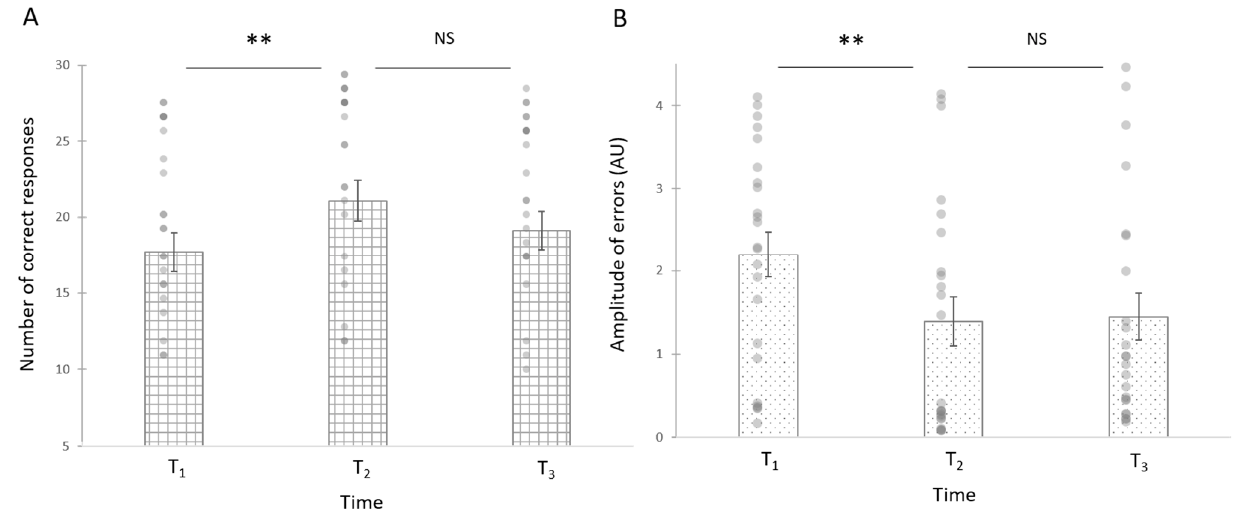
Figure 3. Number of correct responses ( A ) and amplitude of localization errors (( B ), in arbitrary units, AU) in the touch body part tasks across time period (T 1 at Baseline, T 2 After the experimental period, T 3 after the control period). NS is for non-significant, ** is for p < 0.01.